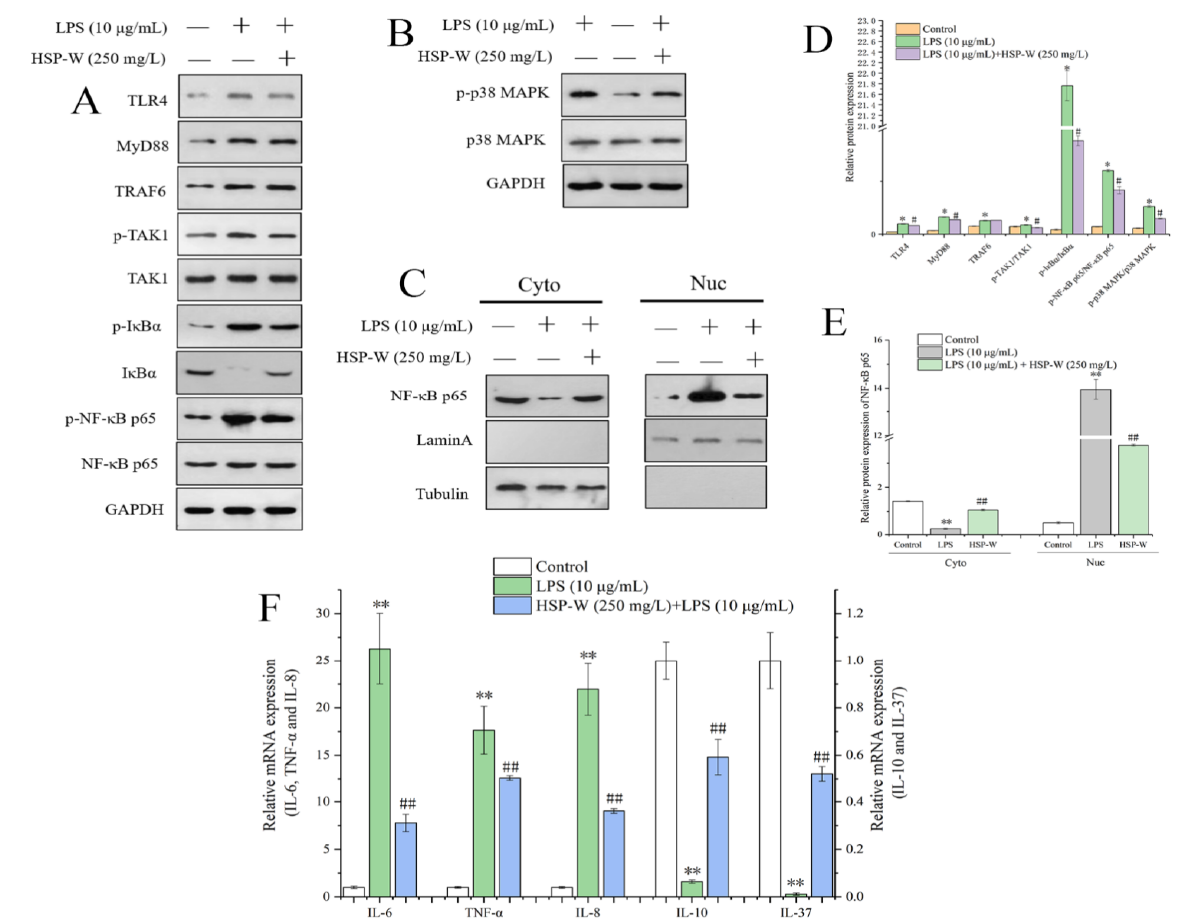
Figure 5. Effects of HSP-W on the TLR4/MyD88/NF- κ B and MAPK signaling pathways. ( A ) Western blot analyses of TLR4, MyD88, TRAF6, p-TAK1/TAK1, p-I κ B/I κ B, p-NF- κ B/NF- κ B, ( B ) p-P38/P38, ( C ) nucleo-cytoplasmic separation of NF- κ B, ( D ) densitometric quantification of the phosphorylated and total proteins, ( E ) densitometric quantification of NF- κ B in the cytoplasm and nucleus, ( F ) relative mRNA expression of proinflammatory and anti-inflammatory cytokines. The values represent the mean ± SEM ( n = 3). * p < 0.05 and ** p < 0.01, compared with the control groups, # p < 0.05 and ## p < 0.01, compared with the LPS-treated cells.